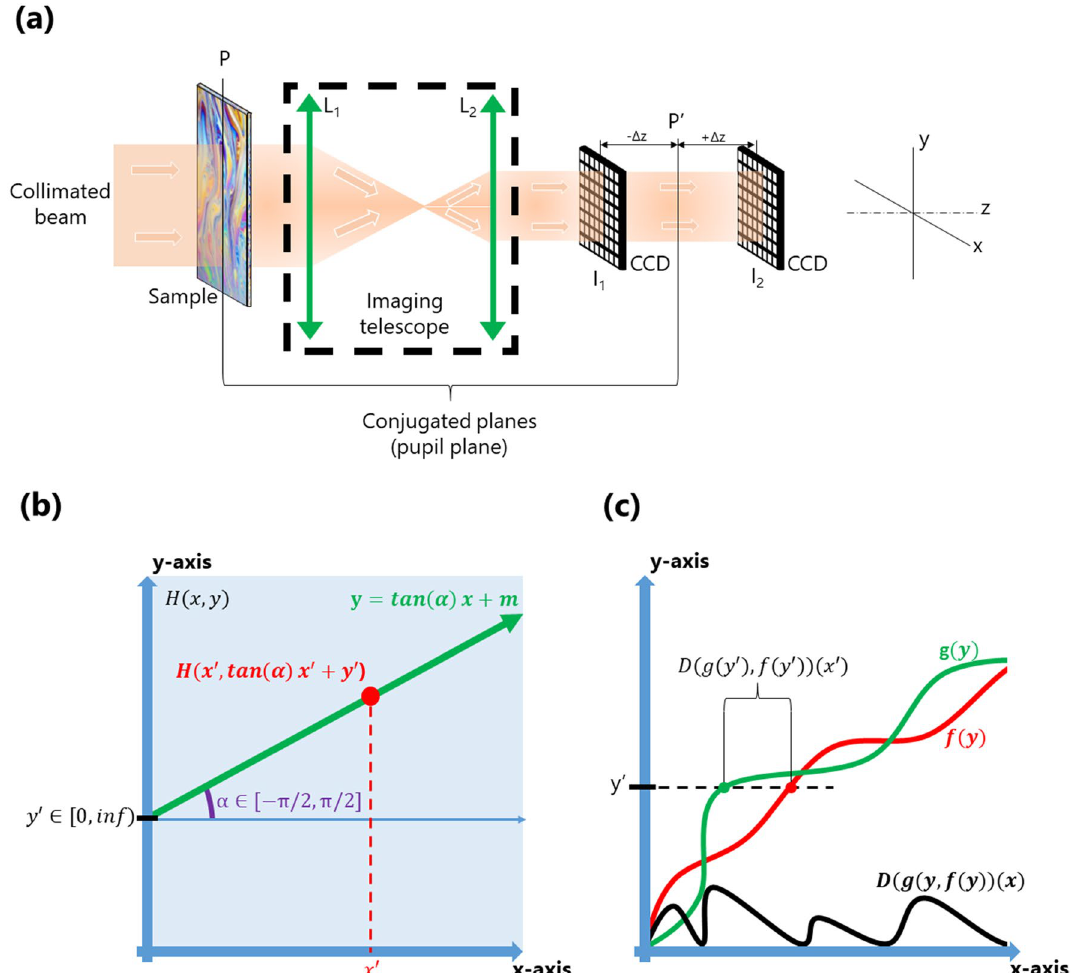
Figure 1. (a) Basic optical setup of the wavefront phase intensity (WFPI) technique for transparent samples; (b) graphical representation of Eq. (1), (c) graphical representation of Eq. (2). P pupil plane, L lens, I intensity image, CCD charge-coupled device, P ’ conjugated pupil